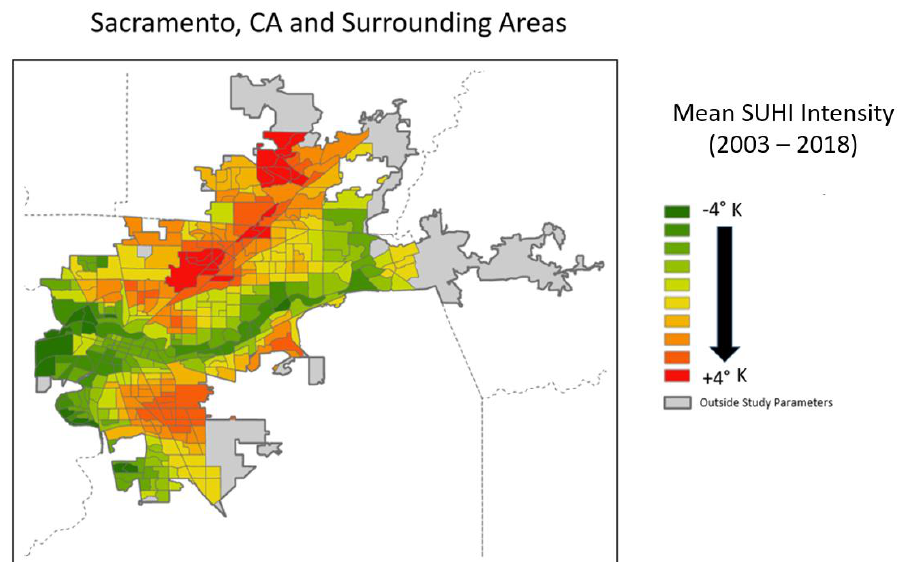
Figure 2. Example city used in the study demonstrating the overlay, or lack thereof, between the SUHI intensity dataset (classed) and census designated urban areas. Only census tracts that are spatially aligned with the SUHI intensity dataset are used in the study. Dashed lines represent county boundaries, also notice the presence of spatial autocorrelation or the clustering of similar values.